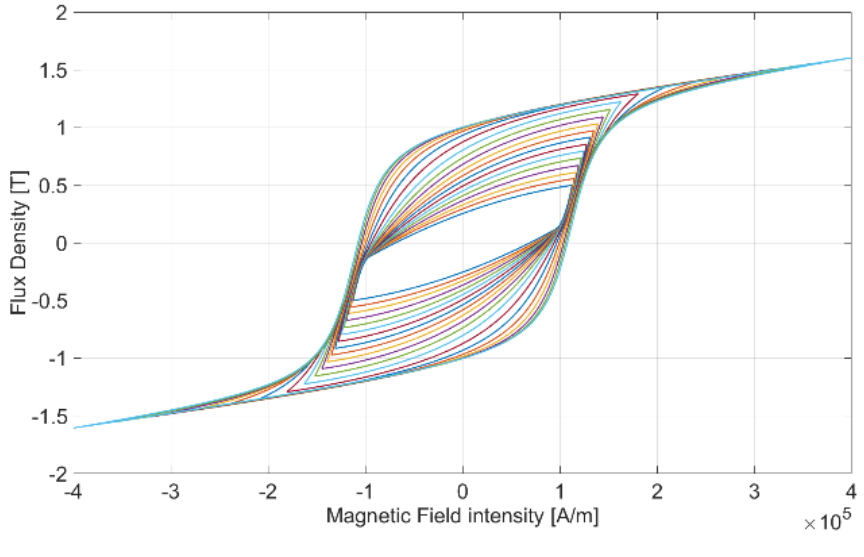
Figure 4. Minor loops construction.